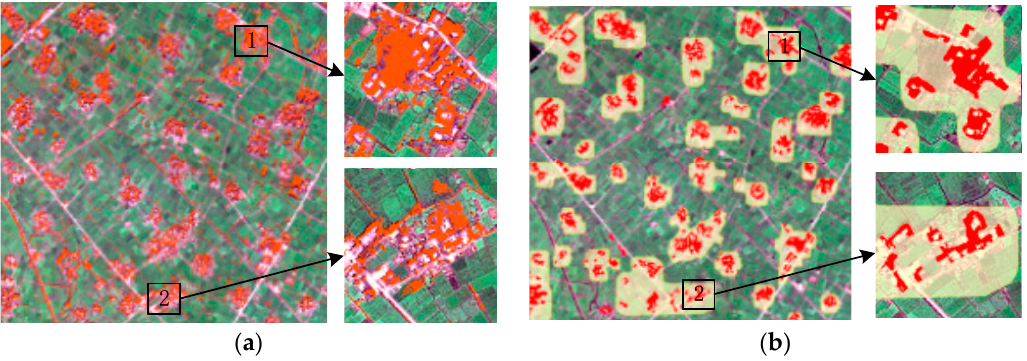
Figure 7. Building results of two compared models: ( a ) gCRF; ( b ) “SR+gCRF”.